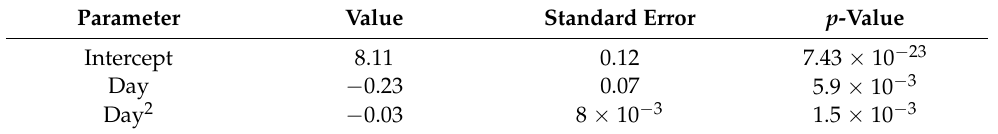
Table 2. Regression parameter estimates for the Quantity of Serratia detected during 9 days from 80 mg bran inoculated with 6 × 10 9 CFU Sm culture and stored at 30 °C.